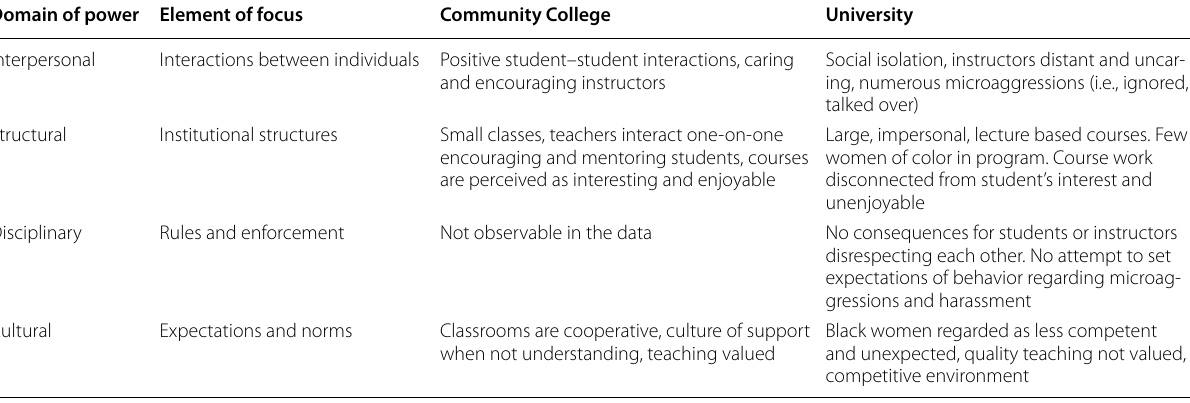
Table 3 Collins’s domains of power identified in interviews with Black women community college and university students Domain of power Element of